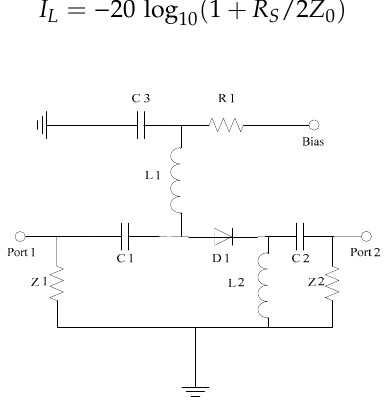
Figure 6. Circuit schematic of the series PIN switch.